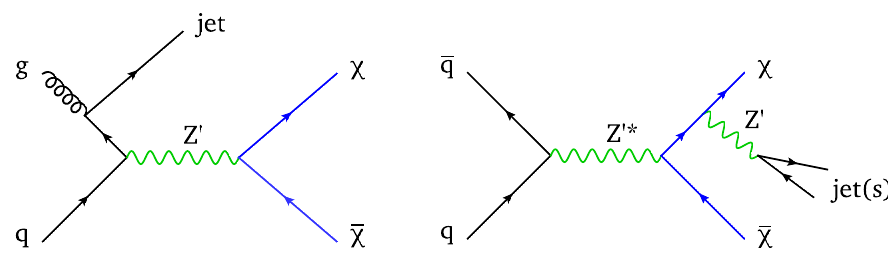
Figure 2 . Feynman diagram for a monojet event in (cid:31) (cid:22) (cid:31) production at LHC, due to initial state (left) and (cid:12)nal (right) state